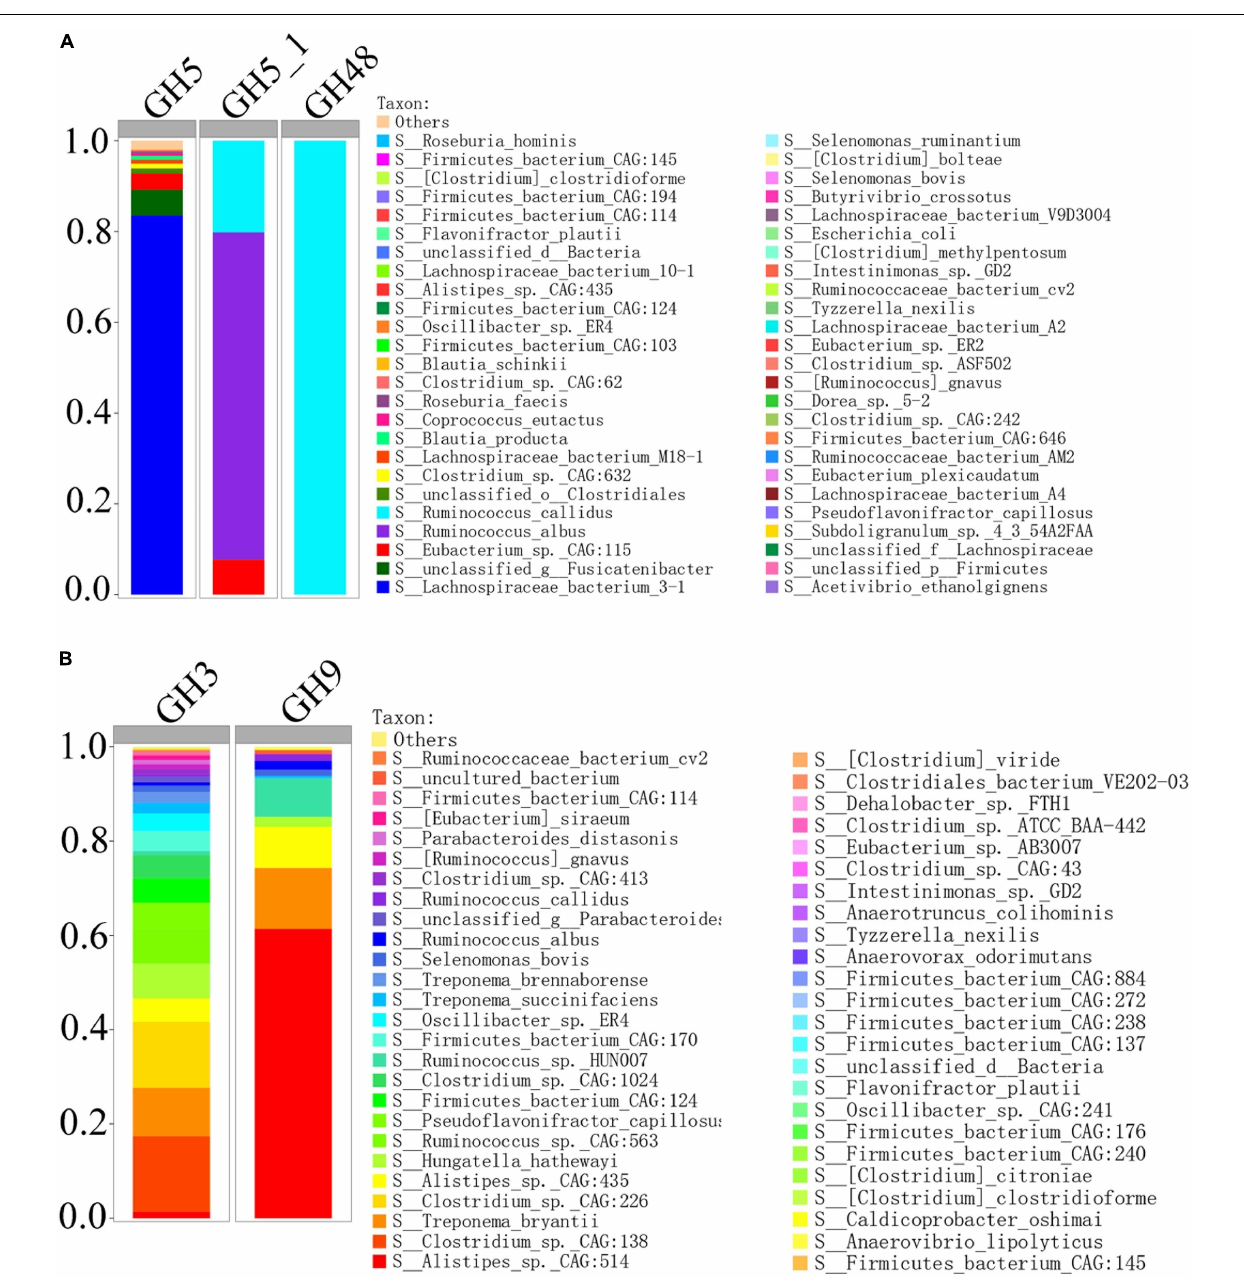
FIGURE 7 | Percent contributions of GH5, GH5_1, and GH48 (A) and GH3 and GH9 (B) from 62 bacterial biomarkers of H_NDF group and 54 bacterial biomarkers of H_ADF